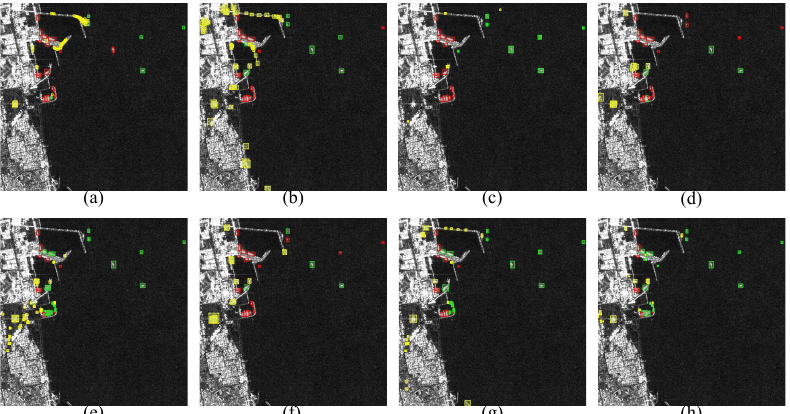
Figure 11. Visualization of detection results with different detectors in scene 2. ( a ) RetinaNet. ( b ) ATSS. ( c ) YOLOv5. ( d ) Faster R-CNN. ( e ) Double-head R-CNN. ( f ) Cascade R-CNN. ( g ) Dynamic R-CNN. ( h ) The proposed